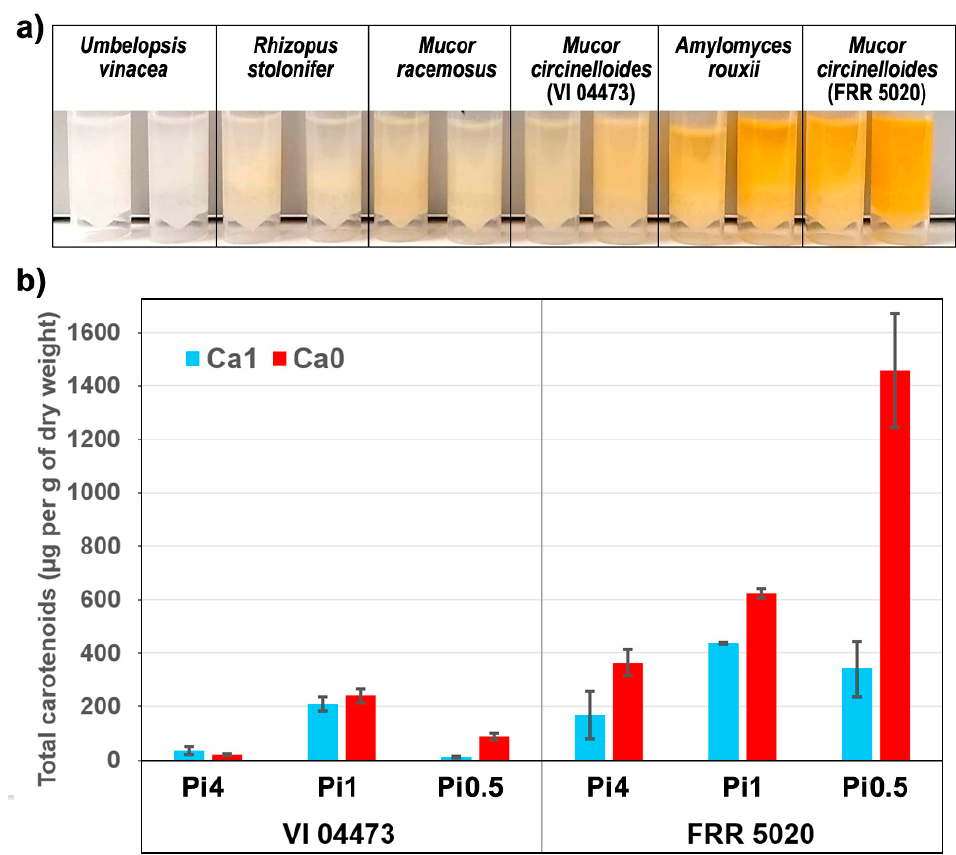
Figure 2. ( a ) Image of disintegrated fungal biomass of samples grown under Pi0.5 condition, with (Ca1, tube1) and without (Ca0, tube 2) calcium. ( b ) Total carotenoid content of the two Mucor circinelloides strains grown under six different conditions (average values and range based on measurements of two biological replicates).